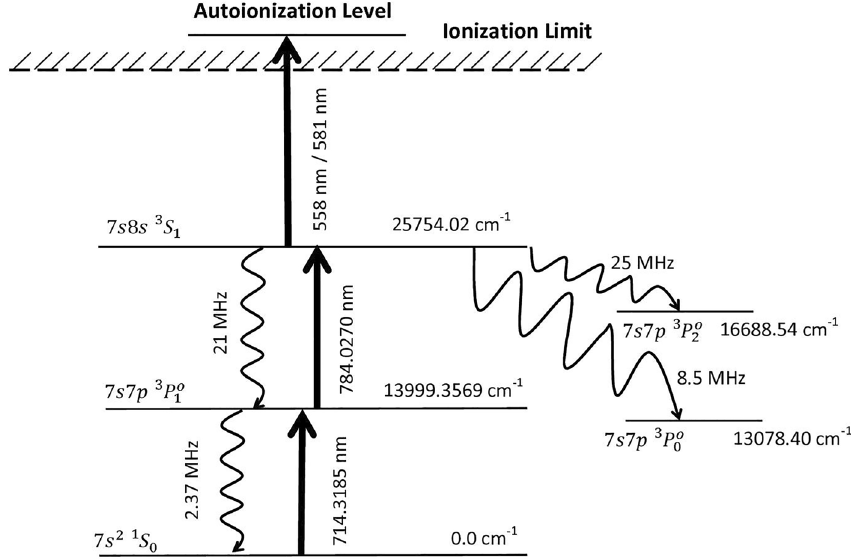
Figure 1. Schematic diagram of the photoionization scheme of Radium (not to